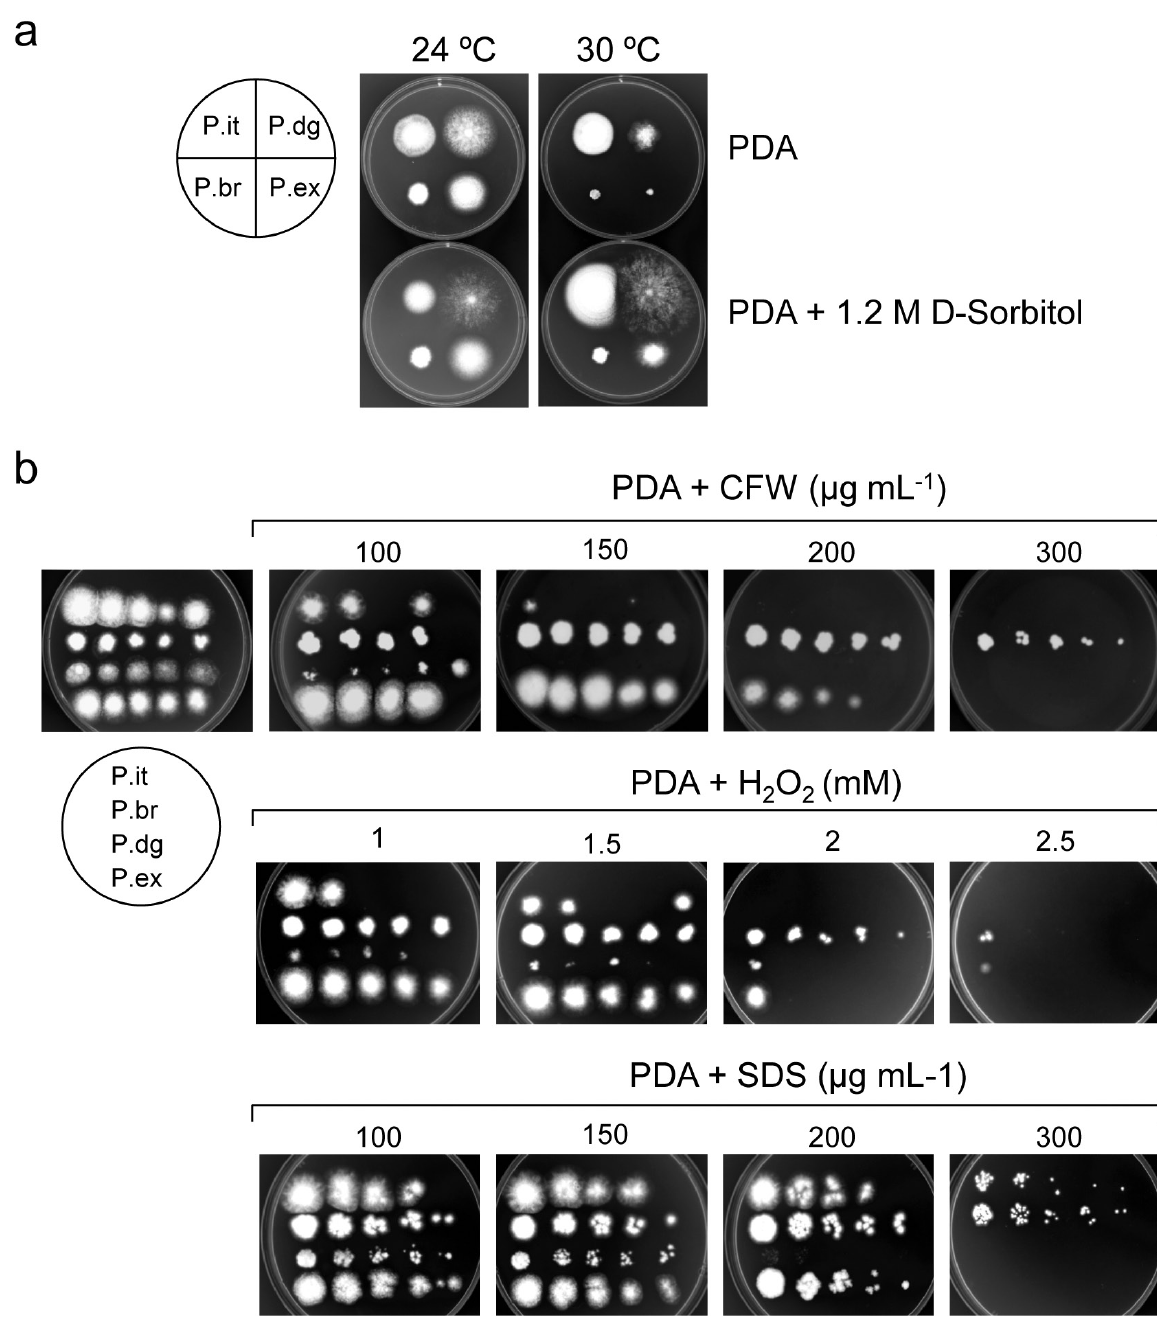
Figure 4. Thermosensibility and susceptibility of Penicillium strains to CFW, SDS and H PHI-1 (P.it), P. brevicompactum PHI-8 (P.br), P. digitatum PHI-26 (P.dg) and P. expansum PHI-65 (P.ex) were spot- ted onto PDA plates containing the compounds at the final indicated concentrations in order to test (a) their ther- mosensibility and osmotic remediability and (b) their susceptibility to antimicrobials with different modes of action. Plates were incubated for 3-4 days at 24ºC or 5-7 days at 30ºC to monitor fungal